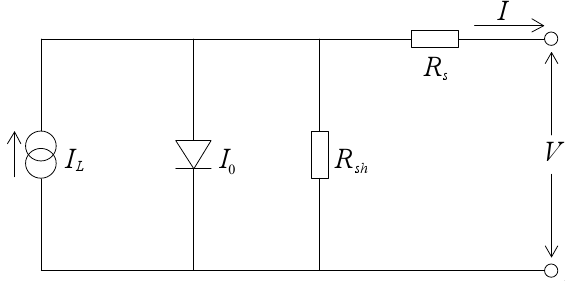
Figure 2. One-diode equivalent circuit for a PV panel.